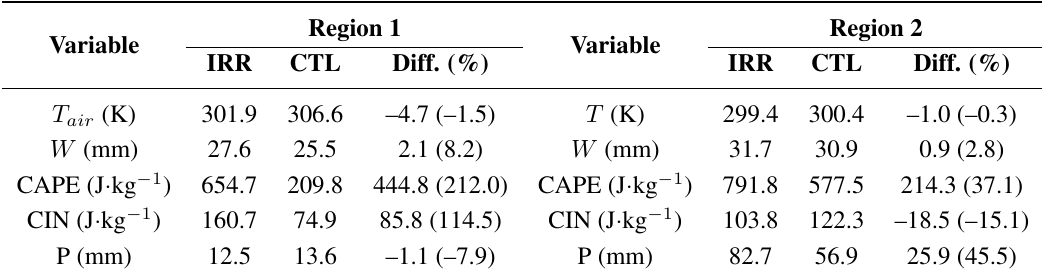
Table 2. As in Table 1 but for atmospheric quantities.